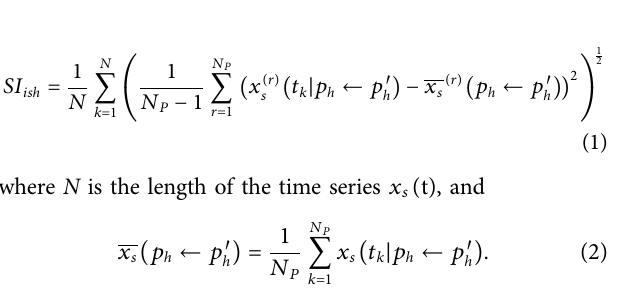
FIGURE 2 | Conversion of the SIF format interactions into a (hyper-)graph structure.